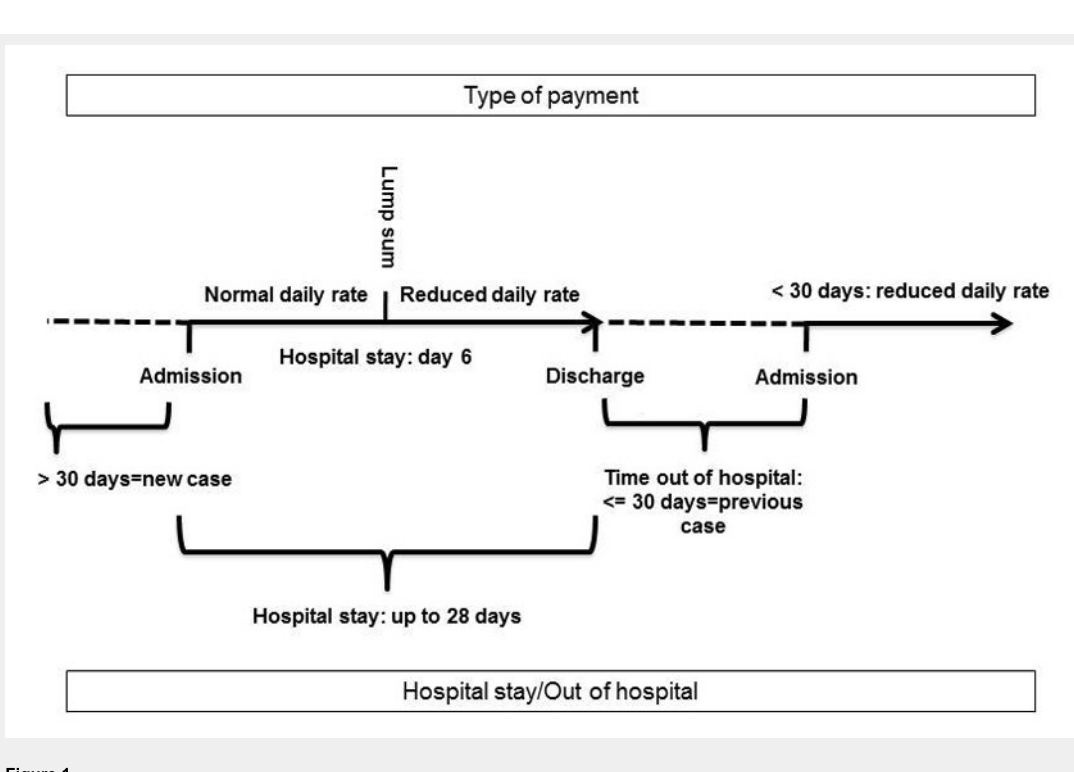
Figure 1 New Remuneration System (NRS): Illustration by several inpatient